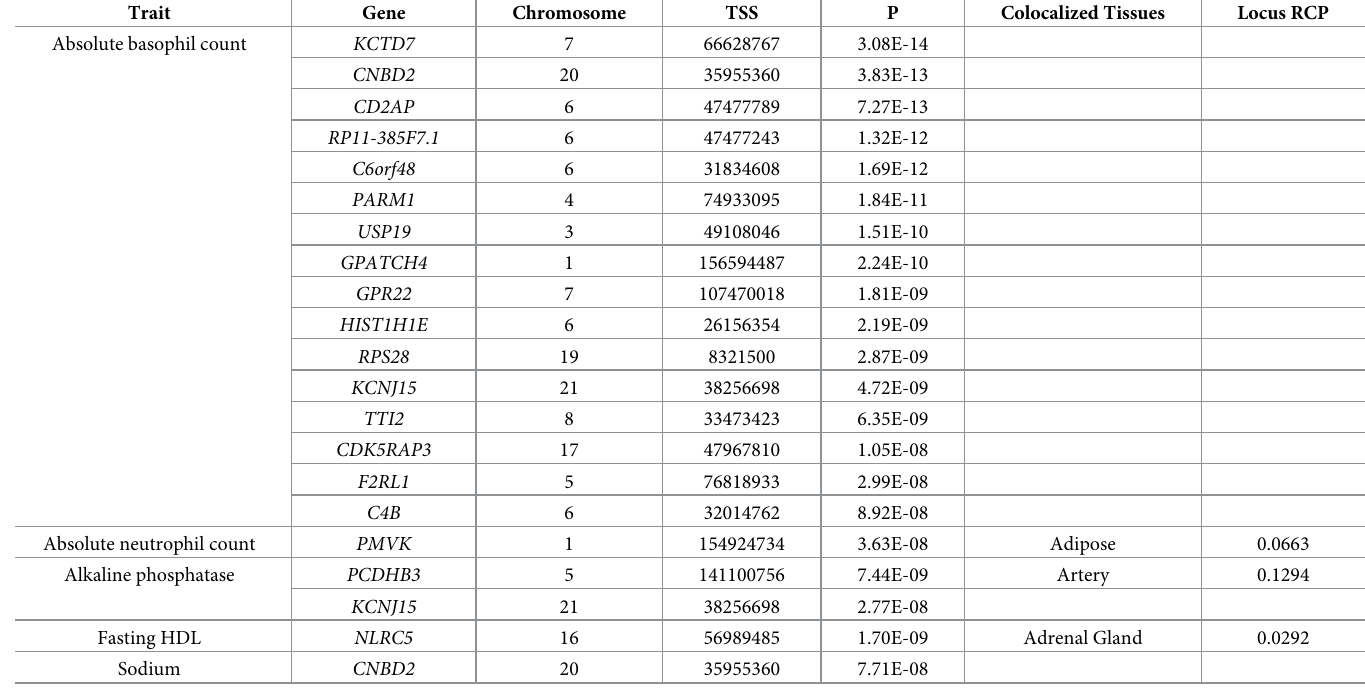
Table 4. Novel associations related to HIV baseline laboratory values identified by TSA-TWAS.